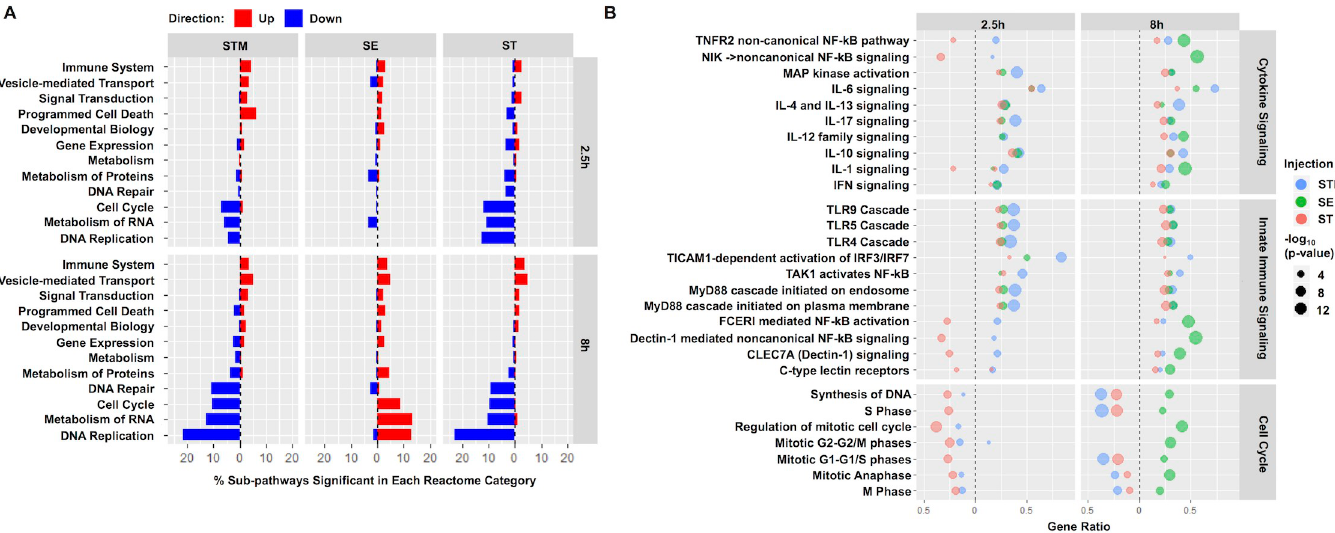
Fig 3. Immune system and cell cycle pathways encompass the predominant increases and decreases in gene expression during infection. (A) Fraction of sub- pathways clustering into the major Reactome cellular processes. Significantly upregulated (red) or downregulated (blue) genes were analyzed using ReactomePA and pathways were clustered into major cellular processes from the Reactome database. Major cellular processes with at least 12 significant sub-pathways in at least one infection condition were included with the proportion of significant pathways out of the entire group plotted on the x-axis. (B) Dot plot showing top pathways enriched from the Reactome database. Pathway coverage shown as gene ratio with significantly upregulated pathways shown on the right of the dotted line and downregulated pathways on the left. Dot size represents -log 10 (p-value) of enriched pathway during HIO infection with STM in blue, SE in green and ST in red. Significant pathways were determined based on P value <